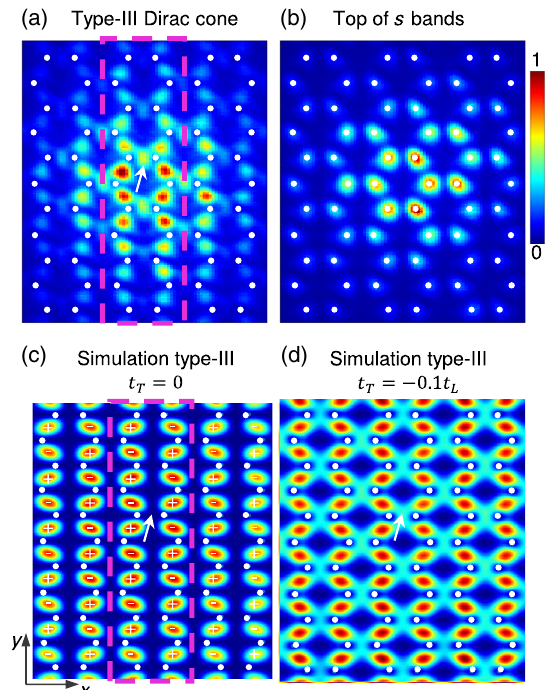
FIG. 6. Real-space wave functions of the flat band at the type- III Dirac cones. (a) Measured real-space photoluminescence intensity for β ¼ 1 . 5 at the energy of the type-III Dirac cone in Fig. 5(c) ( E ¼ 1 . 56752 eV). The white arrow points to the emission observed in between the horizontal links. (b) Same for the top of the s bands ( E ¼ 1 . 56577 eV), for which the usual hexagonal emission is observed (here shown as a reference). The white dots mark the center of the micropillars. (c) Calculated ¼ 0 . eigenstate at the energy of the flat band at the Γ point with t T To obtain the real-space distribution, we account for the p and x p shapes of the orbitals in each micropillar. The (cid:2) signs indicate y the sign of the wave function in each lobe. In panels (a) and (c), the dashed rectangles mark the shape of a plaquette state. (d) Same ¼ − 0 . 1 t as panel (c) with t . The arrows highlight one of the T L strained